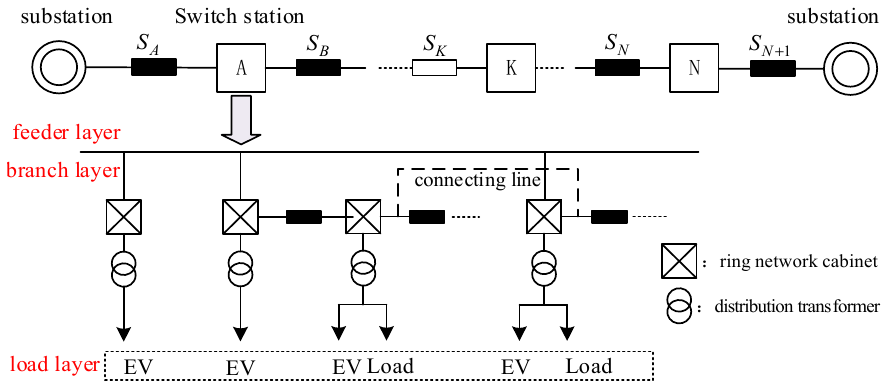
Figure 1. Topological structure of medium-voltage distribution network with EV.